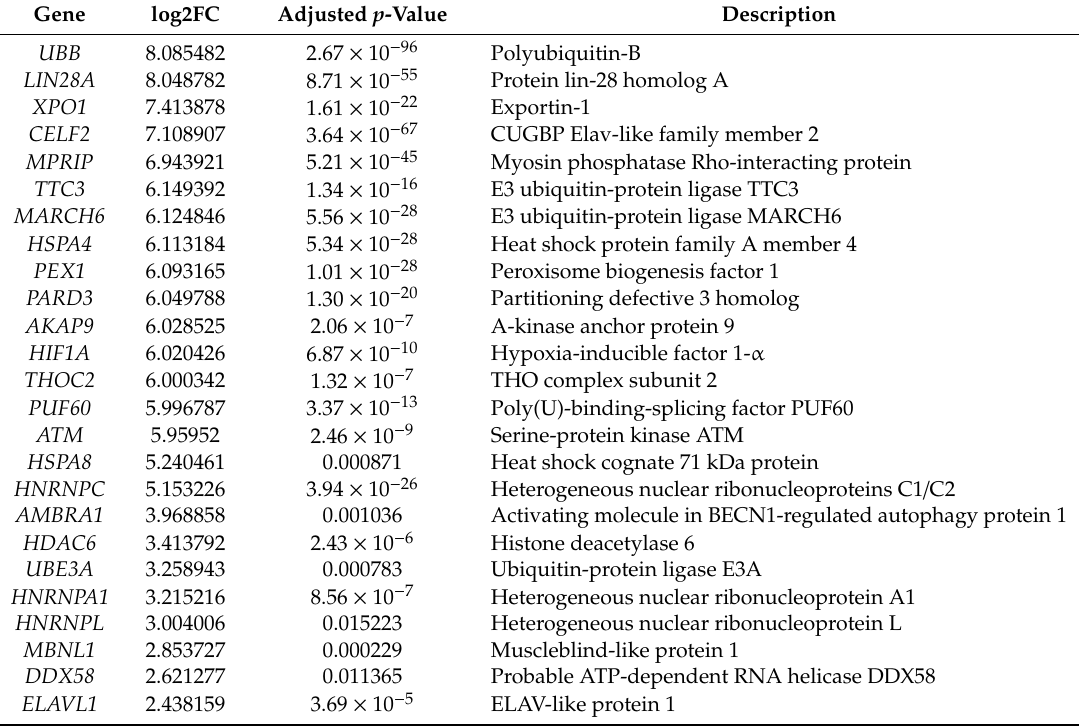
Table 1. List of interacting up-regulated protein-coding genes.